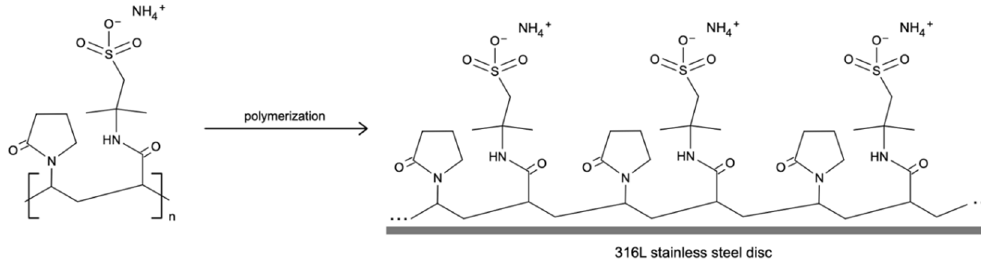
Figure 2. AVC co-polymer chemical structure. Polymerization reaction by drying at the room temperature.